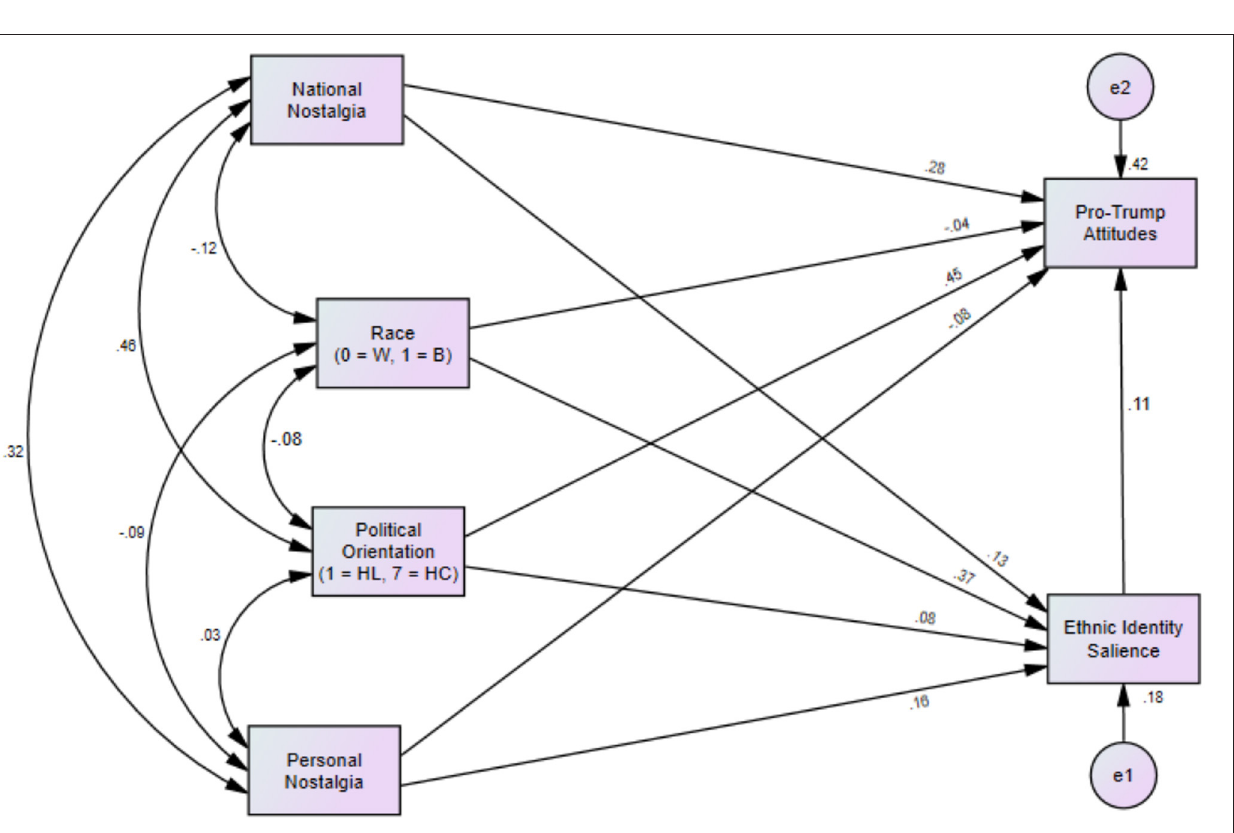
As a final examination of Research Question 1, a second path model (Path Model 2, Figure 4 ) was compared with Path Model 1 to again examine the interaction between nostalgia and ethnic